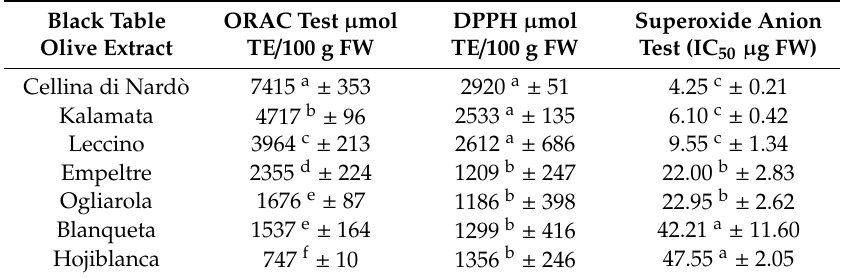
Table 4. Antioxidant activity detected in commercial black table olives of seven di ff erent cultivars. Results are expressed as µ mol of Trolox Equivalents (TE) / 100 g FW (ORAC and DPPH tests) and as IC 50 per µ g FW (superoxide anion assay) of olive pulp. Same letters indicate no statistical di ff erences between averages (Duncan test, n = 3, p =